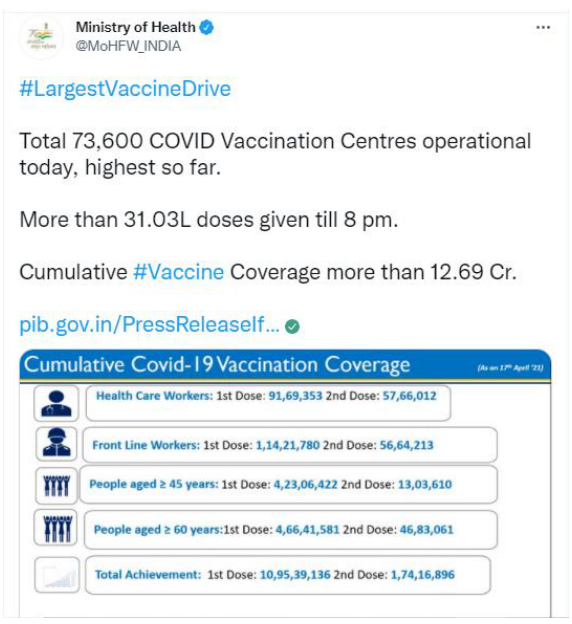
Image 3: Tweets from the Ministry of Health Representing Vaccination Statistics in India (Source: Ministry of Health